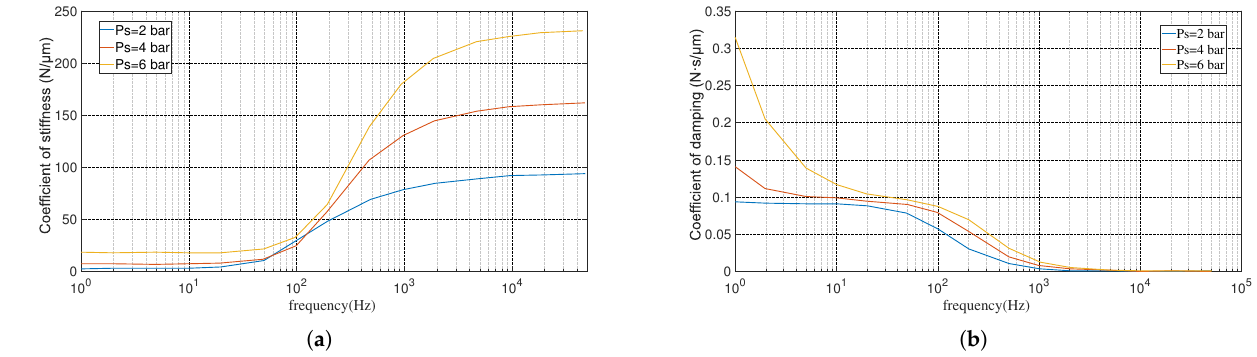
Figure 3. The dynamic characteristics of the gas film under different air supply pressures [41] (orifice diameter = 0.3 mm, gas film thickness = 10 µ m). ( a ) Change of dynamic stiffness with air supply pressures. ( b ) Change of damping with air supply pressures.